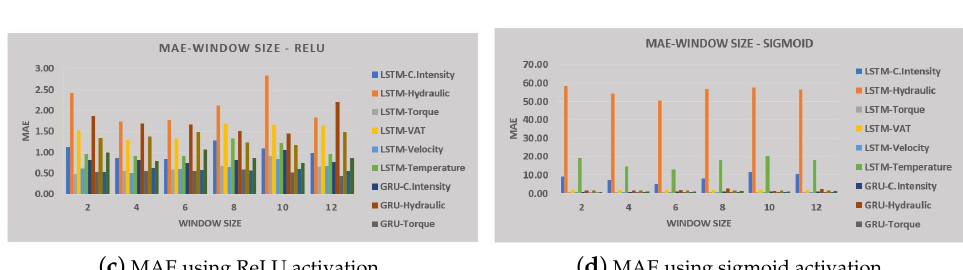
( c ) MAE using ReLU activation ( d ) MAE using sigmoid activation Figure 12. MAPE and MAE errors, for each variable, using ReLU and sigmoid activation functions, for window sizes of 2, 4, 6, 8, 10, and 12 days, using one sample per day. Exact values are shown in Tables 1 and 2 for the best window sizes. Table 1. Summary of the best prediction errors obtained with the LSTM models. Window is the historical window size in days. AF is the output activation function.